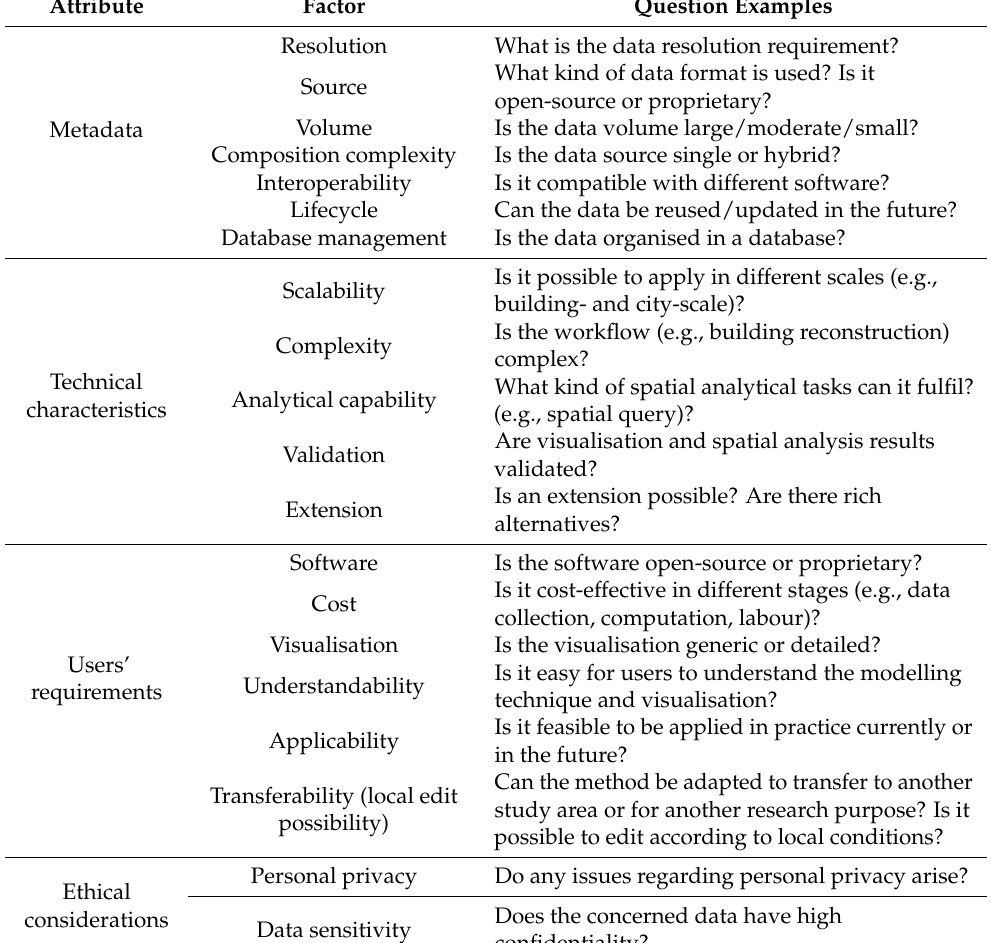
Table 3. The overview of analytical